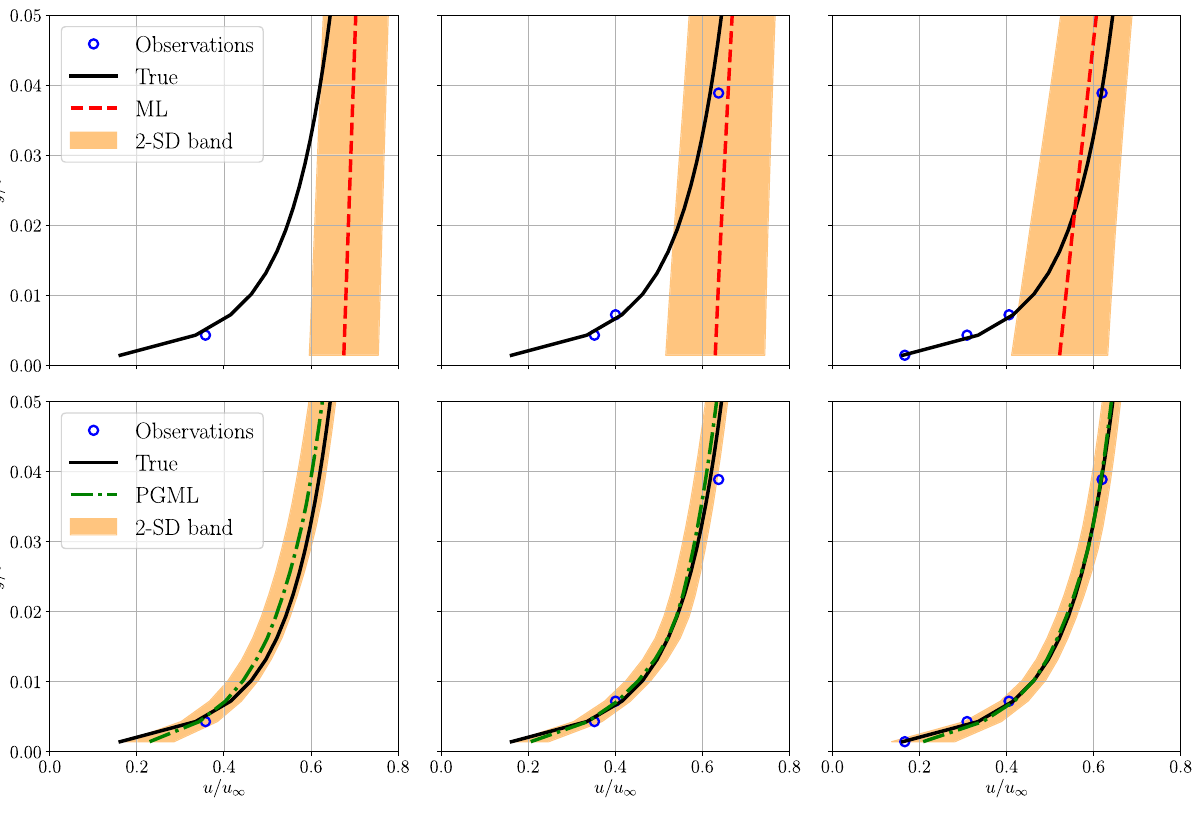
Figure 5. Boundary layer prediction in the near-wall region for turbulent flat plate flow at x / L = 0.5 along with the observations used for training the ML and PGML model. The amount of observations data used for training the model is 5% (left), 10% (middle), and 30% (right). The shaded area corresponds to two standard deviation (2-SD) band.